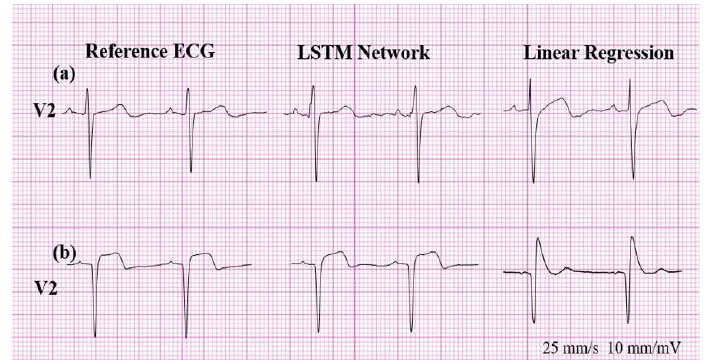
Figure 9. ( a ) False positive for ST elevation and ( b ) false negative result for ST depression.